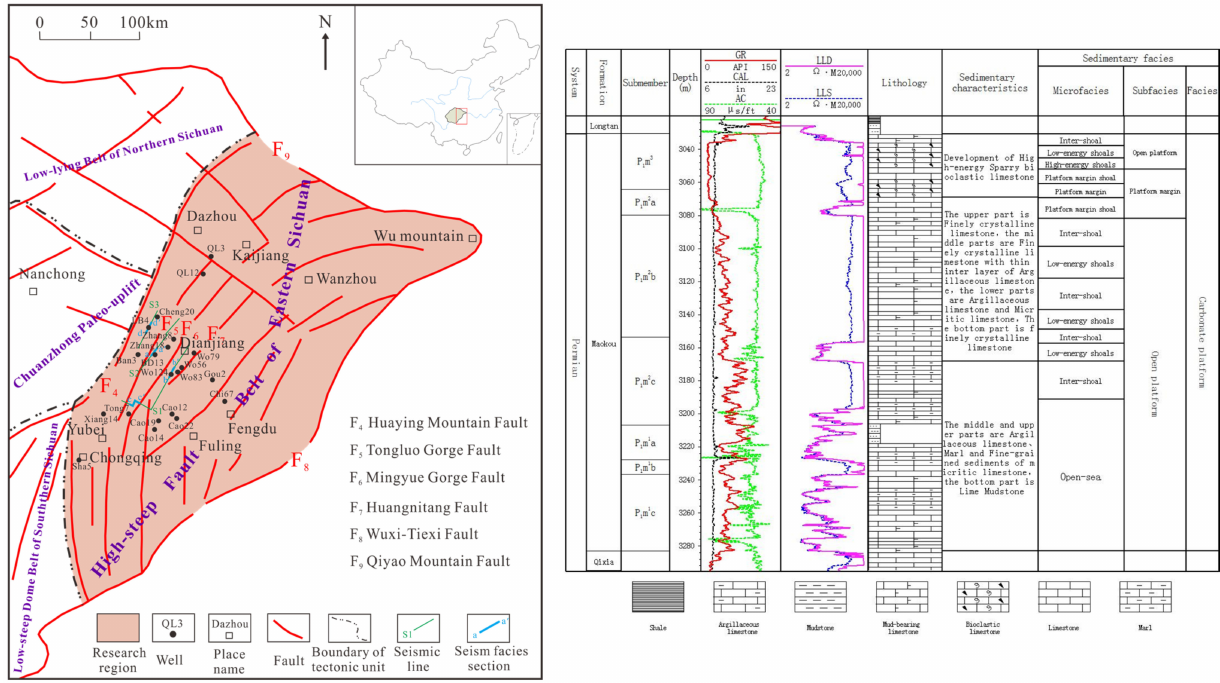
Figure 1. Geographical location map of study area showing relevant fault lines and wells (modified from [21]), and comprehensive histogram of Well